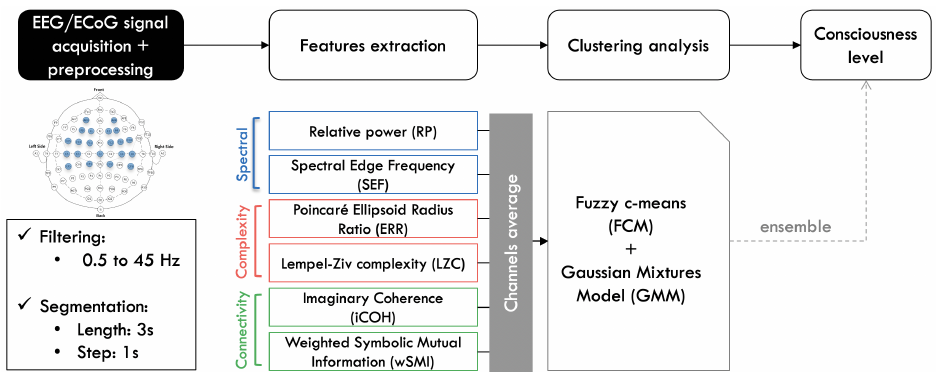
Figure 2. Signal processing and analysis pipeline. The ECoG signal is filtered and segmented, before different features were extracted from it. Each feature is then averaged across all channels before performing the clustering analysis. The consciousness level of the patient is then inferred from the obtained results